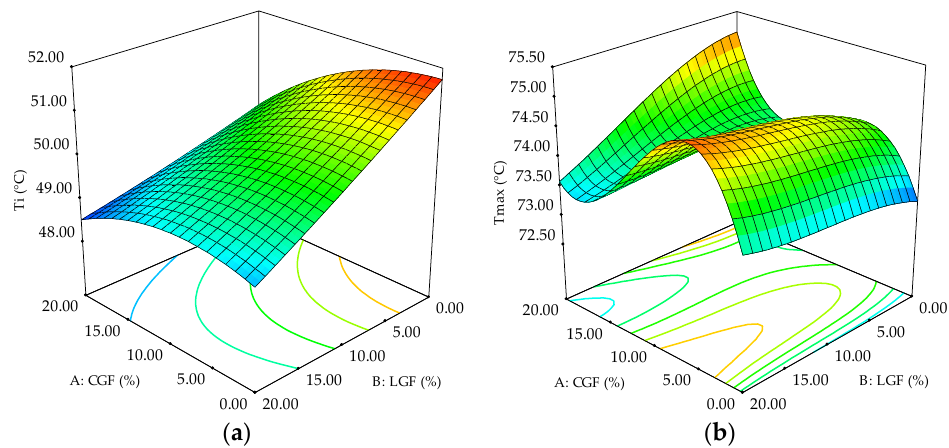
Figure 9. Response surface plot of ( a ) initial gelatinization temperature (T i ) and ( b ) maximum gelatinization temperature (T max ) as a function of chickpea germinated flour (CGF) and lupin germinated flour (LGF) addition. Table 4. Characteristics of the optimal and control